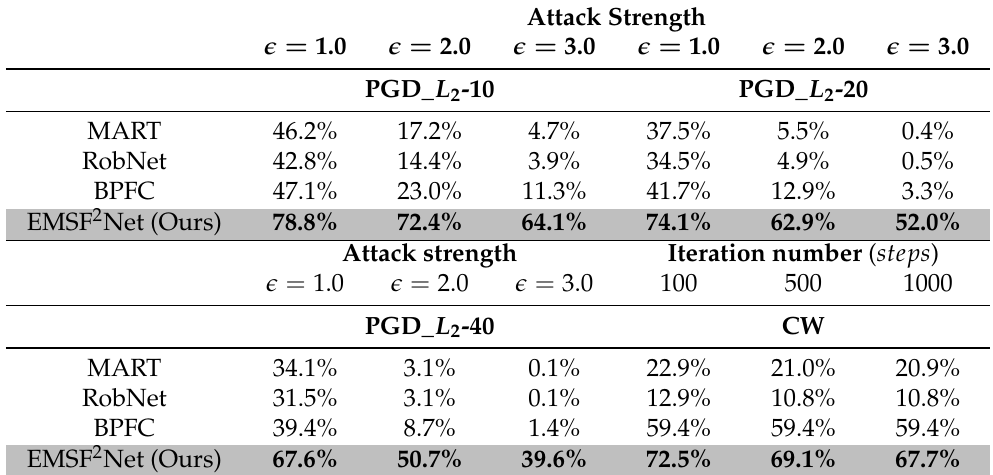
Table 5. Robust accuracy against adversarial attacks using the L 2 -norm on the CIFAR-10 dataset. The lightgray row represents the results of the proposed method, and the bold results represent the best